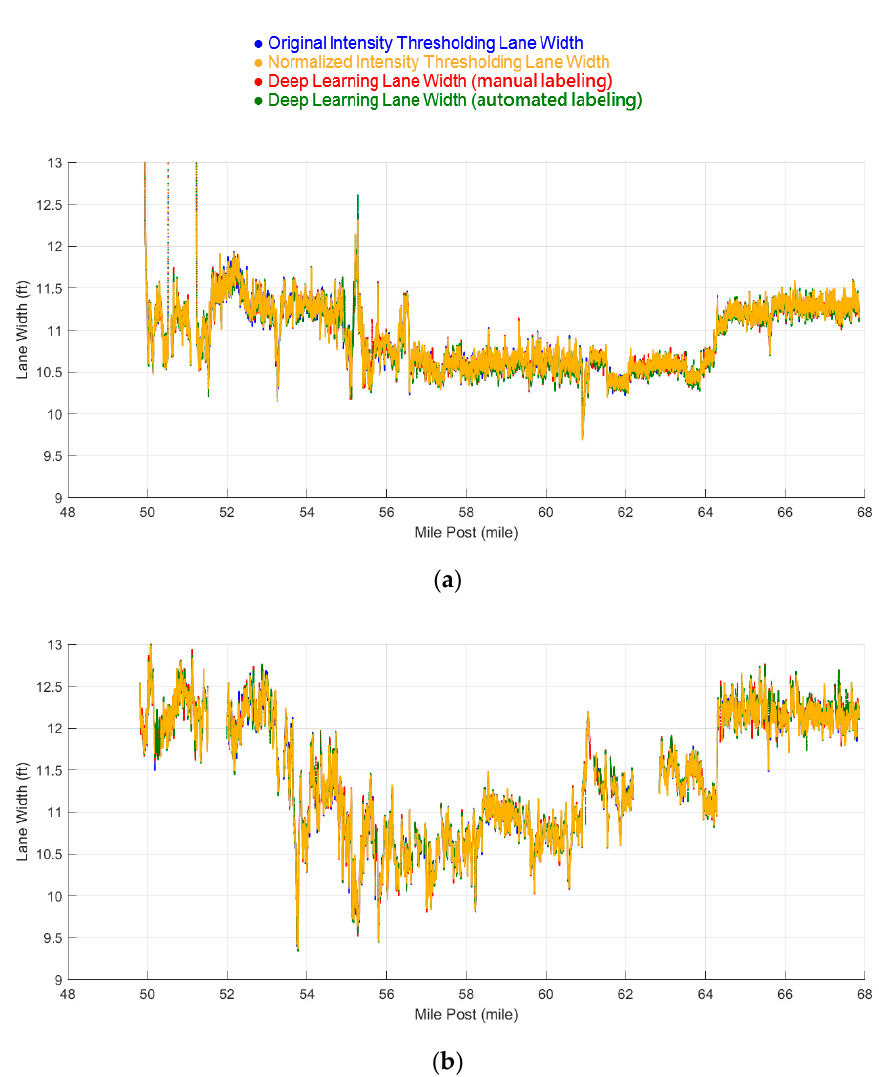
Figure 28. Estimated lane width values in ( a ) lane 1 and ( b ) lane 2 for dataset 1. Table 9. Lane width di ff erence statistics for di ff erent lane marking extraction strategies in dataset 2.